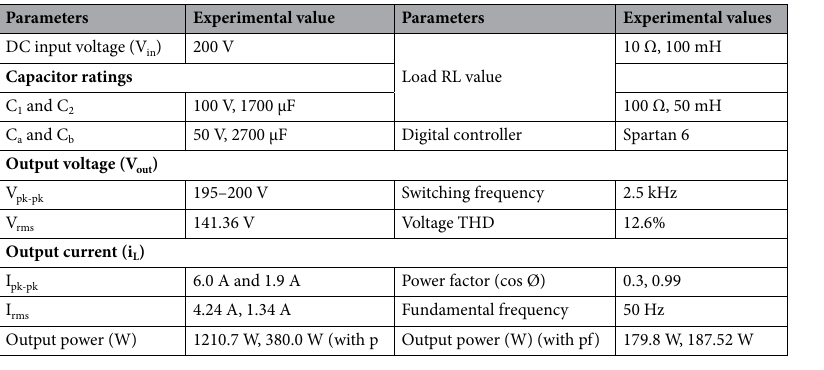
Table 5. System parameter